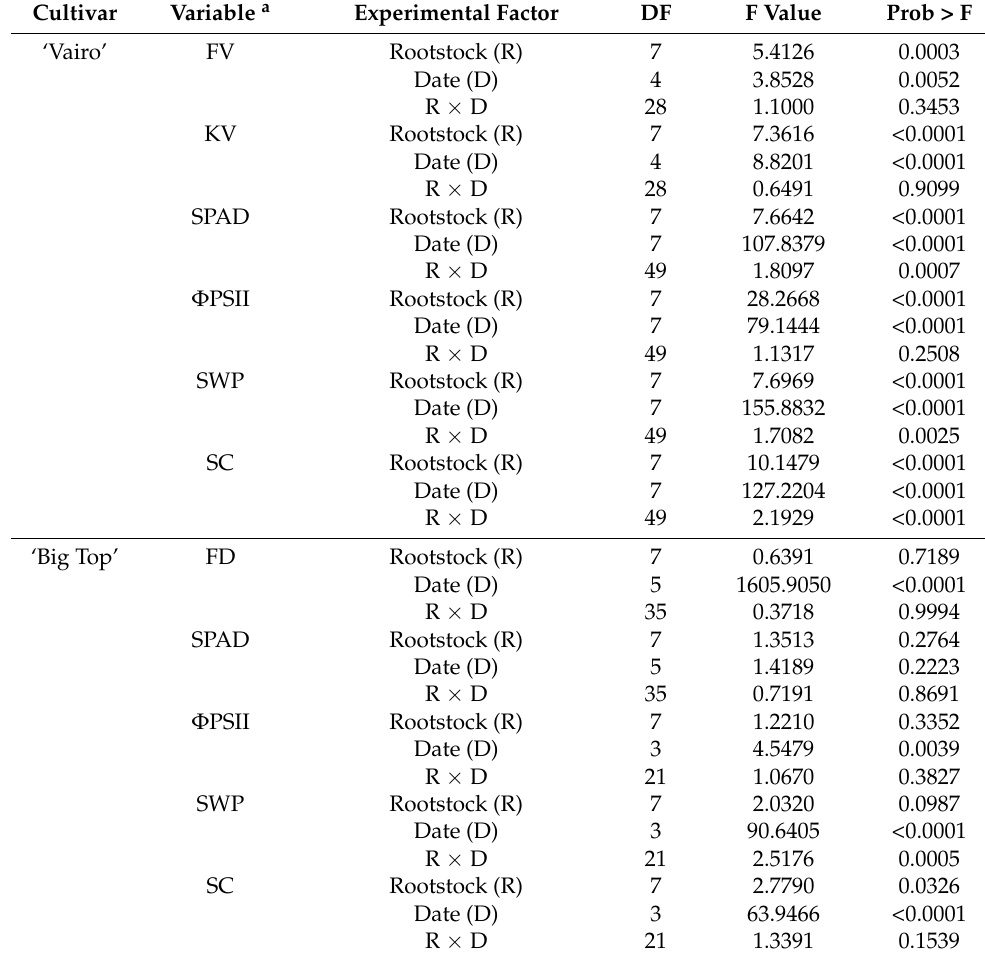
Table 2. Statistical significance of rootstock, date, and the interaction between rootstock and date, based on agronomical and physiological assessments made before harvest, corresponding to eight- year-old ‘Vairo’ almond trees and ten-year-old ‘Big Top’ nectarine trees. Cultivar Variable a Experimental Factor DF F Value